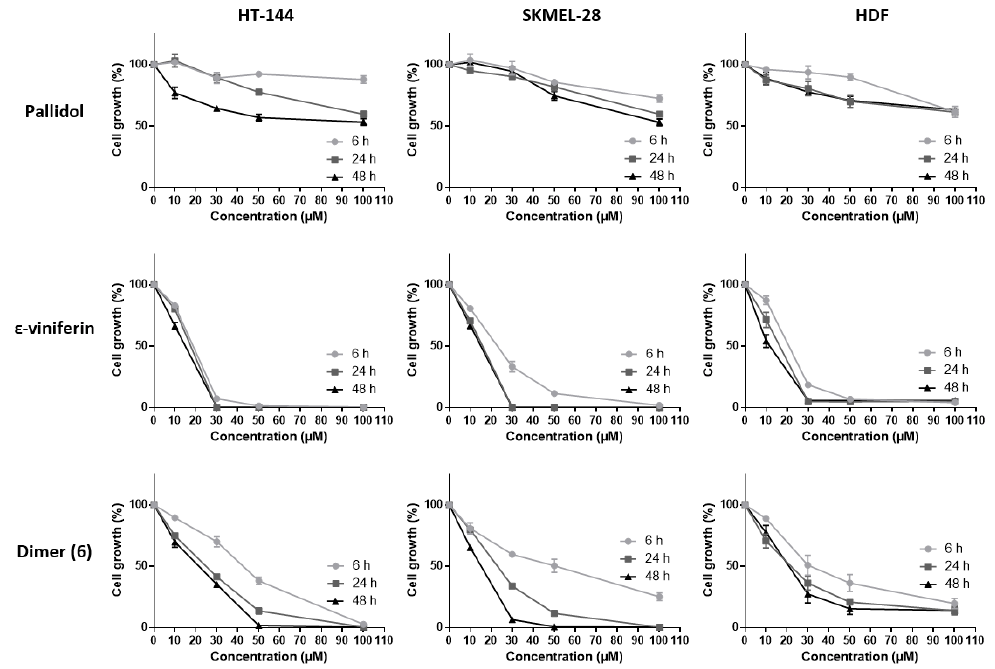
Figure 4. Cell viability inhibition of bio-produced resveratrol oligomers. HT-144, SKMEL-28 and HDF cells were treated with various concentrations (10–100 µ M) of pallidol, ε -viniferin and dimer ( 6 ), three bio-produced reveratrol oligomers, for 6, 24 and 48 h. Cell viability was determined by the MTT assay. The final volume of ethanol was 0.01% and 0.1% for 10 and 100 µ M concentrations, respectively. Data are expressed as the means ± SD of 3 independent experiments. Each experiment was performed in